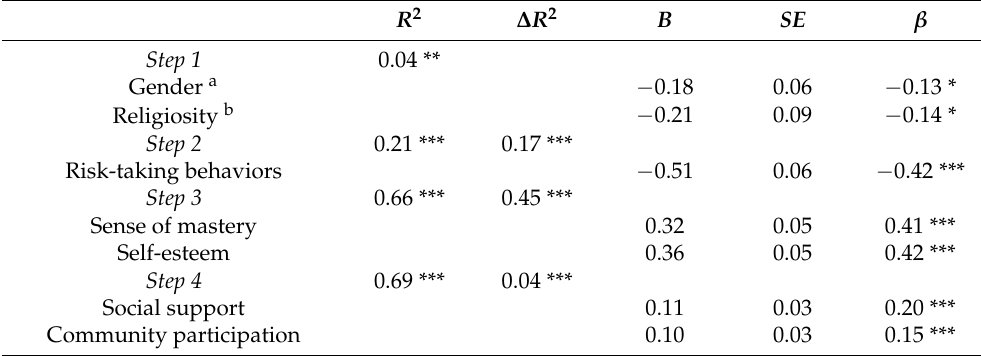
Table 2. Contribution of background and personal and environmental variables to explaining life satisfaction: hierarchical multivariate linear Regression.